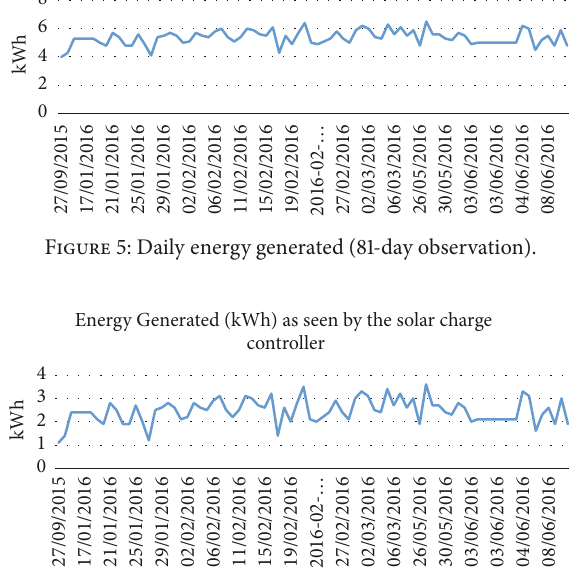
Figure 6: Daily energy generated to charge the battery (81-day